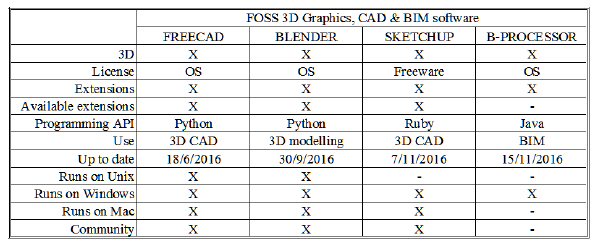
Table 3. FOSS 3D graphics, CAD and BIM